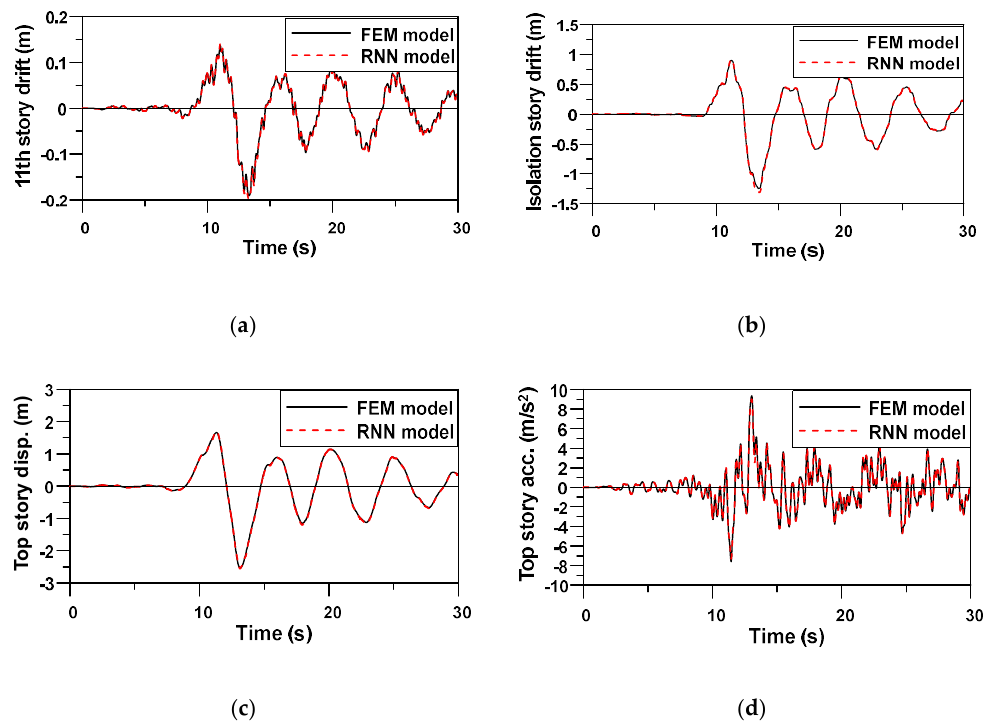
Figure 13. Comparison of the time history responses of Example 2 between FEM and RNN models (EQ No. 13): ( a ) 11 th story drift time history; ( b ) Isolation story drift time history; ( c ) Top story displacement time history; ( d ) Top story acceleration time history.